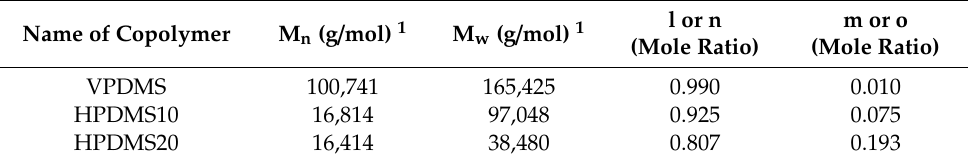
Table 1. Characterization of VPMDS and